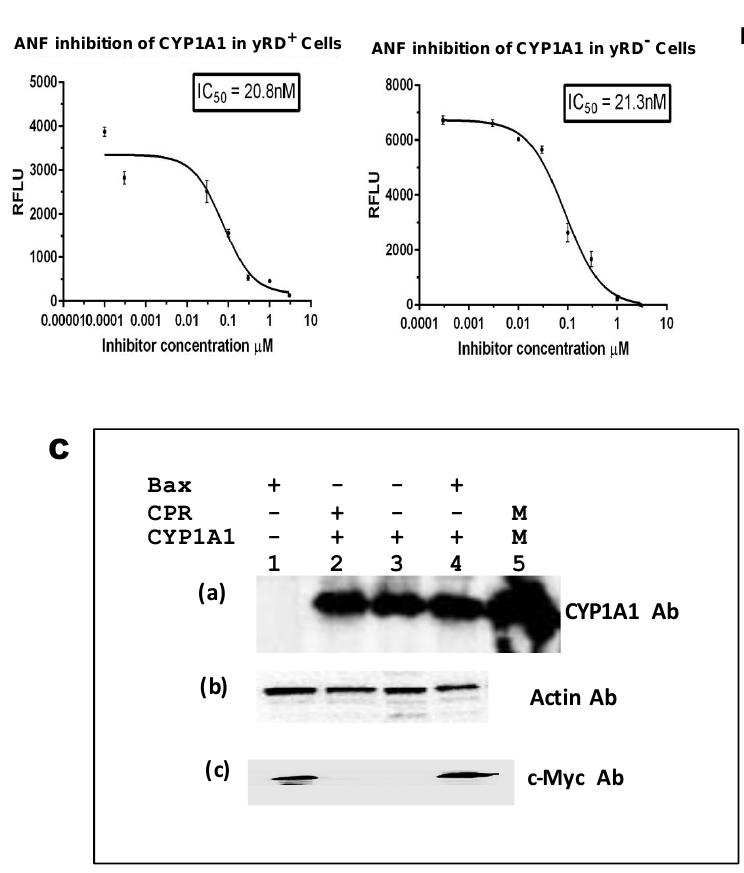
Figure 5. IC 50 of α -naphthoflavone (ANF) for the inhibition of CYP1A1 enzyme expressed within yRD + and yRD − :: Bax cells. ANF’s IC 50 for inhibition of CYP1A1 enzyme that was expressed in live cells. The cells that were used were from strains ( A ) yRD + (+CPR) and ( B ) yRD − :: Bax (–CPR). CYP1A1 enzyme expression was driven by the ethanol-inducible ADH2 promoter (ADH2p). In yRD − cells, Bax expression was driven by the GAL1 promoter (GAL1p), which was de-repressed in ethanol. Recombinant cells were grown for 18 h in YPD liquid medium containing glucose, allowing for around 6 h of induction and de-repression of ADH2p and GAL1p in ethanol (it takes ~12 h for glucose to be utilized and entirely converted to ethanol). Cells were harvested, washed in PBS-saline. The assay included 1 × 10 7 washed cells and 7-ethoxyresorufin (7-ER) as substrates. The x -axis represents the values of the concentration of ANF in µ M (ranges from 0.00001 to 3 µ M) that were incubated with cells for 10 min, the y -axis relative fluorescence units of the fluorescent product formed. The IC 50 values were calculated using the GraphPad Prism software. T. ANF’s IC 50 for inhibition of CYP1A1 Supersomes (insect cell-derived CYP1A1-bearing microsomes; Corning-Gentest, Corning, NY, USA) is 18 nM [35]. ( C ) Western Blotting of lysates from yRD + , yRD − , and yRD-:: Bax cells expressing CYP1A1. Yeast cell lysates (5 µ g of total cellular protein for monitoring CYP1A1 and actin; 50 µ g for Bax) fractionated on SDS / PAGE and probed with antibodies to CYP, Bax and actin proteins after Western blotting. ( a ) Cell lysates probed with a CYP1A1 antibody (Proteintech, 13241-1-AP). Lane 1, yRD − :: GAL1p-Bax (lysate from untransformed cells, which do not contain CYP1A1 episomal plasmid, as negative control). Lanes 2-4: cell lysates from the strains yRD + , yRD − , and yRD − :: GAL1p-Bax transformed with an episomal plasmid that contains a CYP1A1 gene expression cassette under the control of the ADH2 promoter. Lane 2, yRD + :: CYP1A1, lane 3, yRD − :: CYP1A1, lane 4, yRD − :: Bax,CYP1A1, and lane 5, 1.5 pmole of microsomal CYP1A1 (as a positive control; CYP Design Ltd., Leicester, UK). ( b ) Lanes 2-4, same as in ( a ), the cell lysates being probed with an actin antibody (Proteintech, 60008-1-Ig). ( c ) Lanes 2-4, same as in ( a ), the cell lysates being probed with a